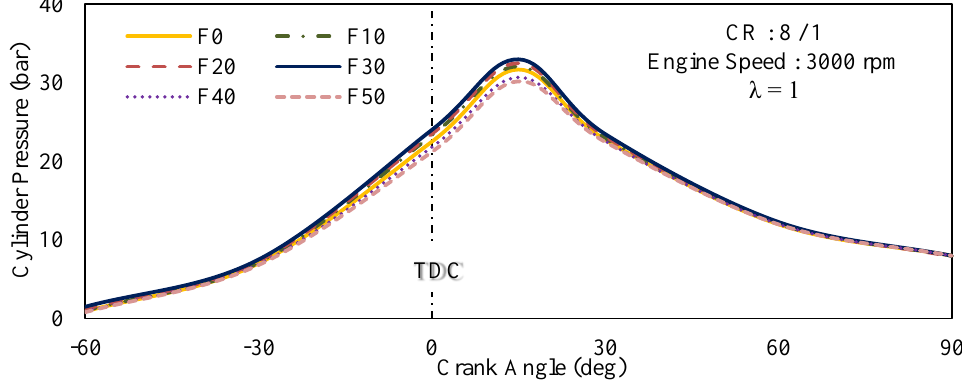
Figure 6. In-cylinder pressure graph at a CR of 8:1.